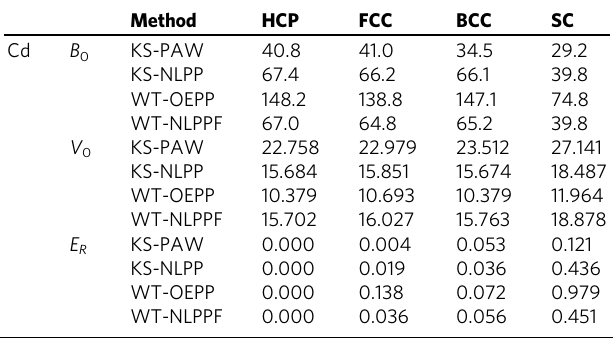
Table 2 B 0 (GPa), E R (eV/atom), and V 0 ( Å 3 /atom) for bulk Cd by KS-DFT and